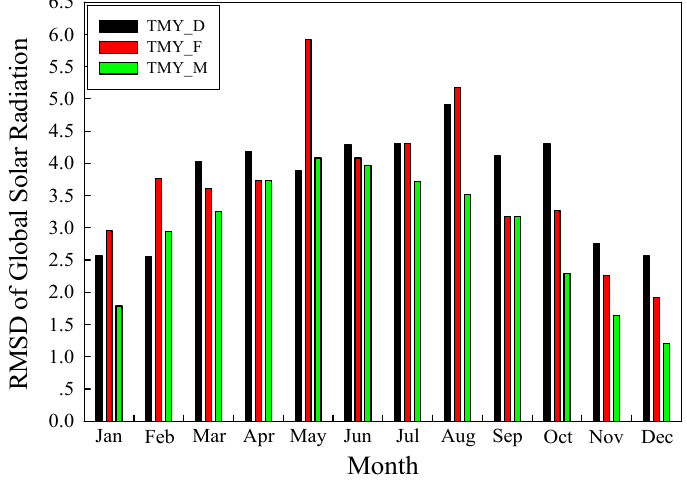
Figure 2. RMSD results of global solar radiation by the three methods in Lhasa.